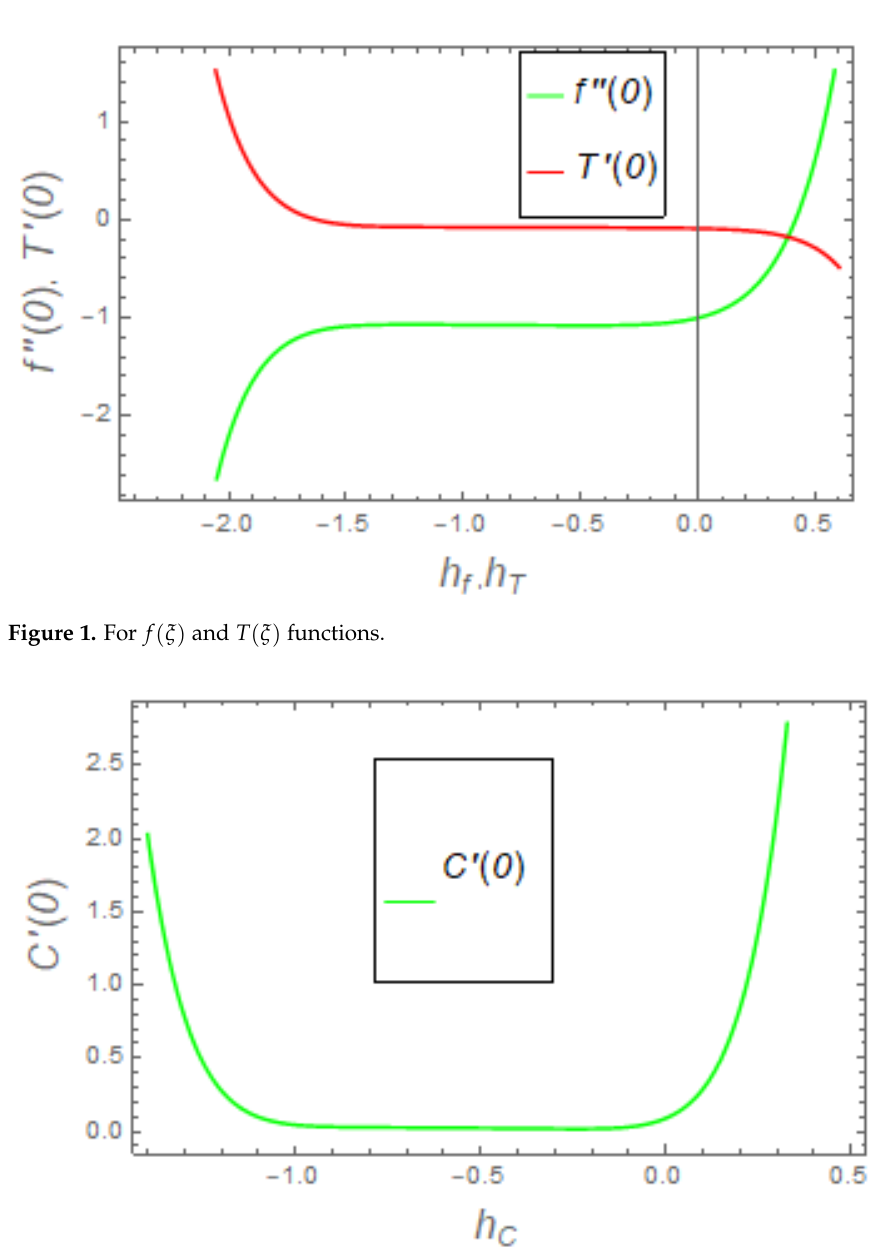
Figure 2. Graph for C ( ξ )